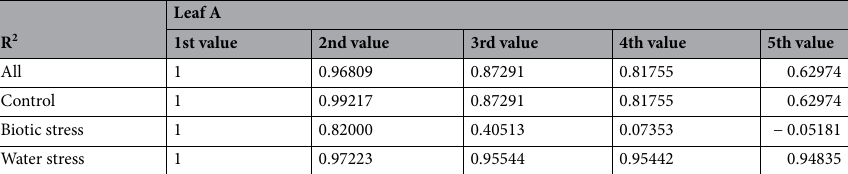
Table 4. Correlation coefficients (R 2 ) between measured and estimated biophoton emission intensities (count/ min) in different experimental groups on Leaf A in each time step using the logarithmic slope parametrization method.